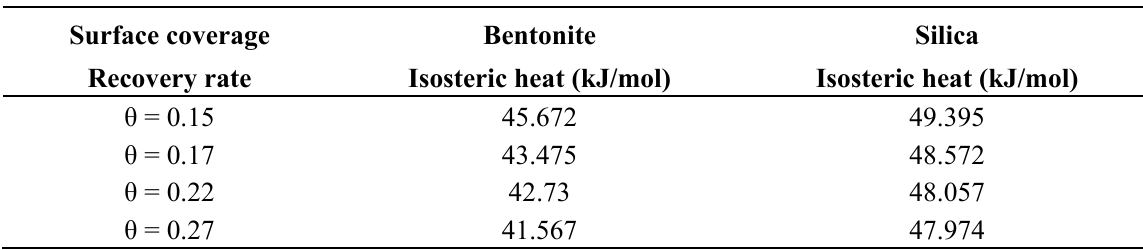
Table 4. Isosteric heats of adsorption at different recovery rates of bentonite and